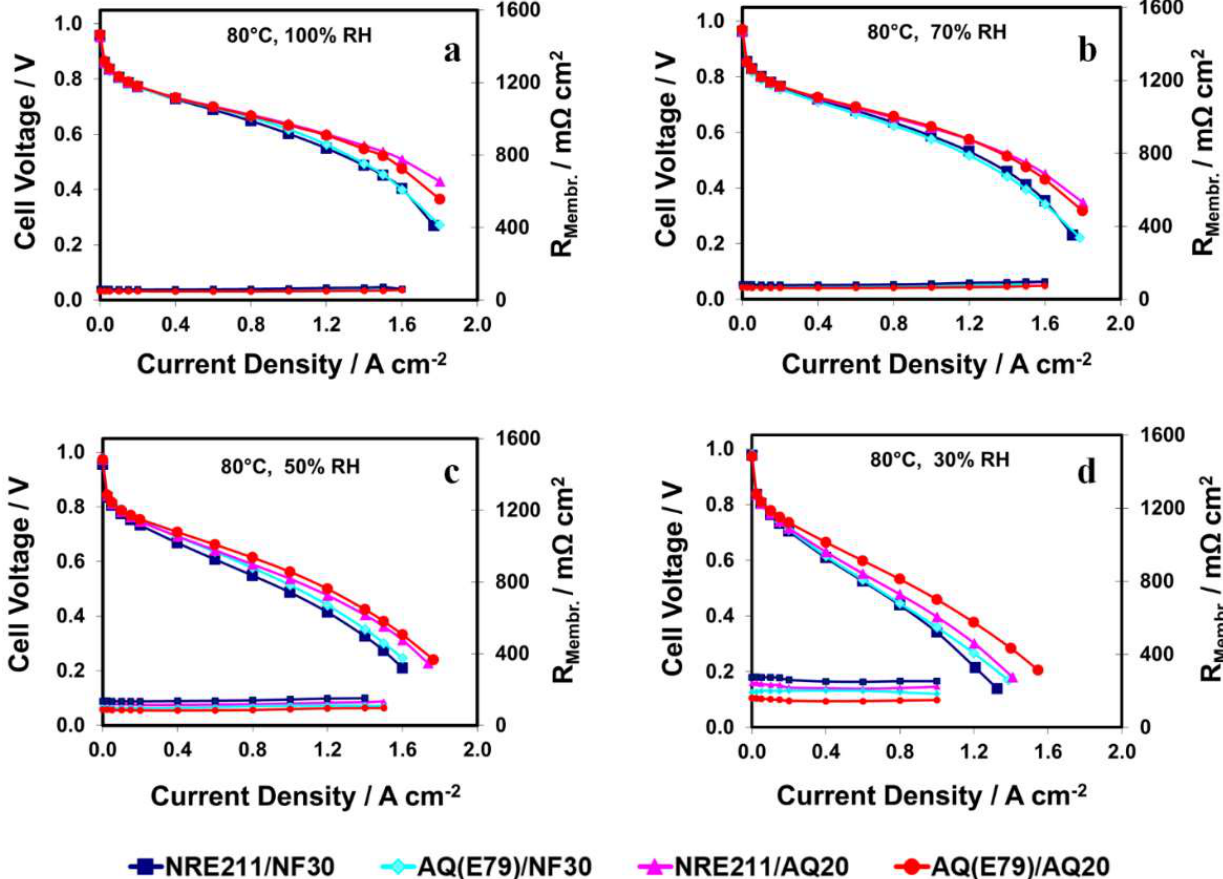
Figure 4. H 2 /air polarization curves and membrane resistance (R Membr .) at 80 °C and RH values of ( a ) 100%; ( b ) 70%; ( c ) 50%; and ( d ) 30%.